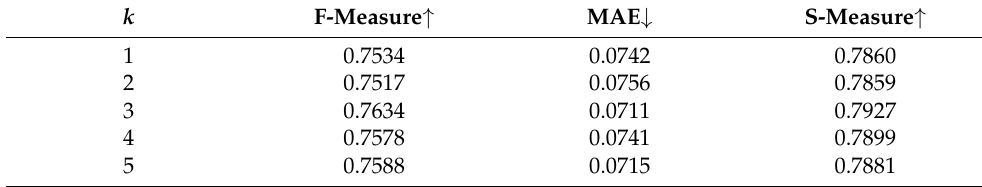
Table 4. Evaluation of different dilation rates with the DUTS-TE datasets. No. F-Measure ↑ MAE ↓ S-Measure ↑ {1,1,1} 0.7634 0.0711 0.7927 {1,2,3} 0.7658 0.0710 0.7988 {1,3,5} 0.7683 0.0694 0.7971 {1,2,4} 0.7768 0.0678 0.8014 {1,4,7} 0.7513 0.0760